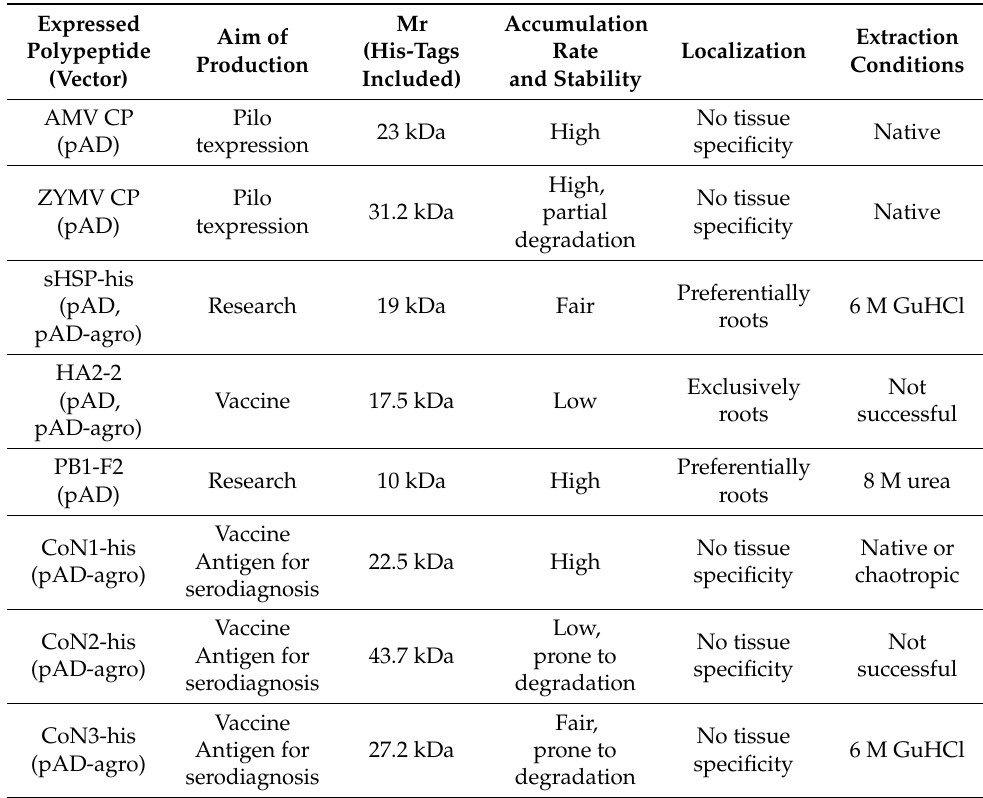
Table 3. Summary of expression experiments using pAD and pAD-agro